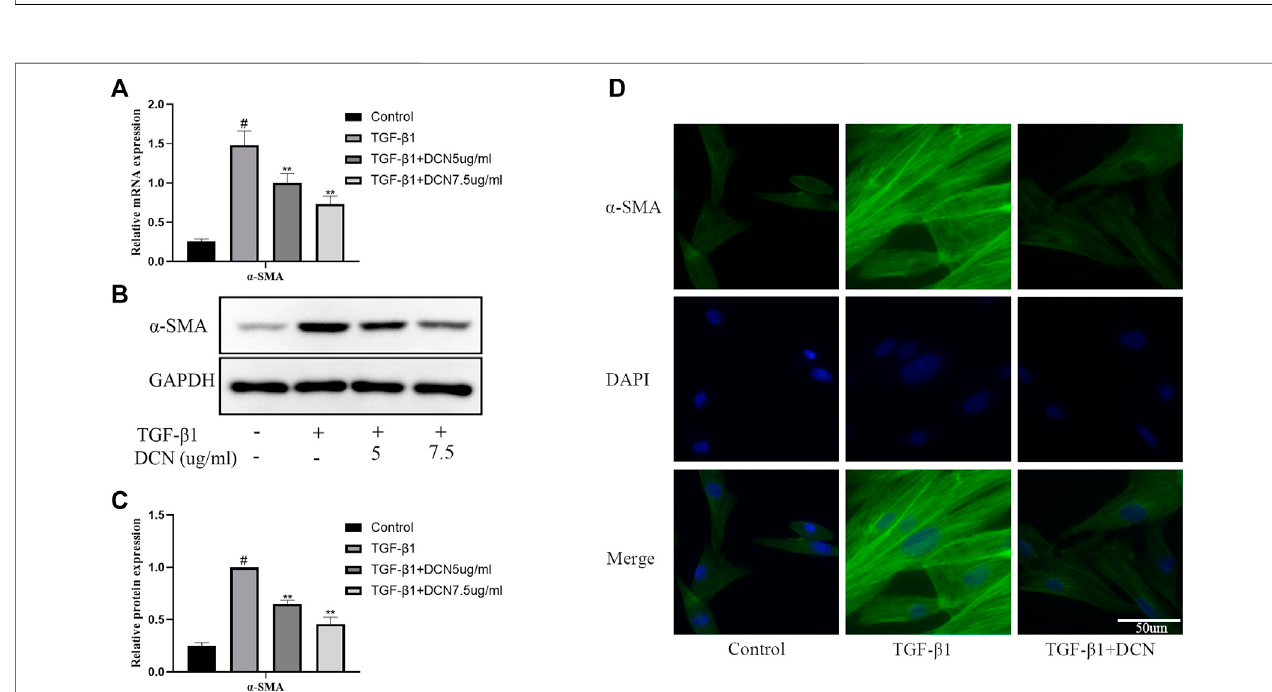
FIGURE 2 | Decorin (DCN) suppresses TGF- β 1-induced transdifferentiation of fi broblasts. Fibroblasts were exposed to TGF- β 1 (5 ng/ml) with or without DCN (5 and 7.5 µg/ml) for 48 h. (A) Gene expression of α -SMA was detected by RT-qPCR. (B) Western blotting and (C) quantitative analysis of α -SMA in each group. (D) The α -SMA was observed by immuno fl uorescence after cells were treated with TGF- β 1 (5 ng/ml) with or without DCN (7.5 µg/ml). # p < 0.05 vs control group; ** p < 0.01 vs TGF- β 1 group.